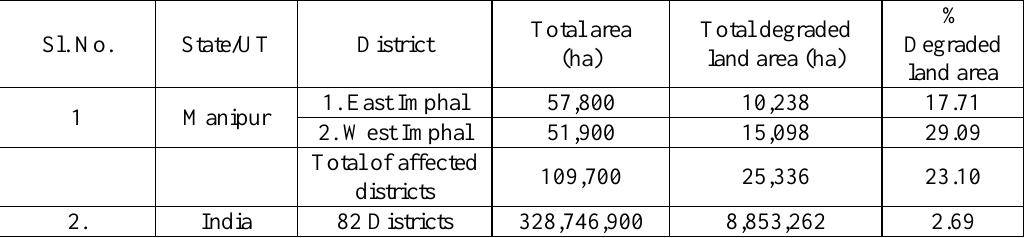
Table 6. State-wise information on degraded land of the district (up to March 2018) [43] Sl. No.